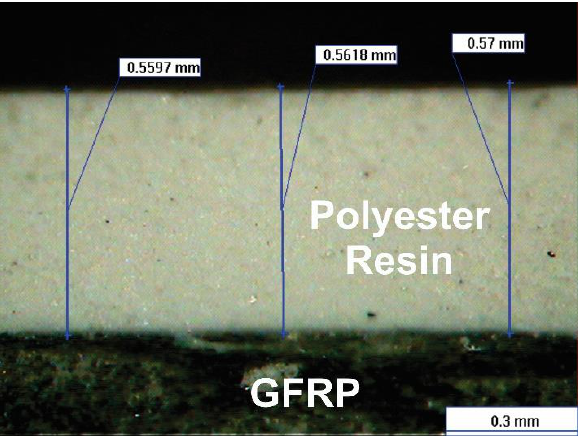
Figure 3. Cross section of glass fiber reinforced polymer and coating of polyester resin. For the measurement of the roughness of the surface of the composite materials, 10 random measurements were made. The average roughness values (Ra) were obtained